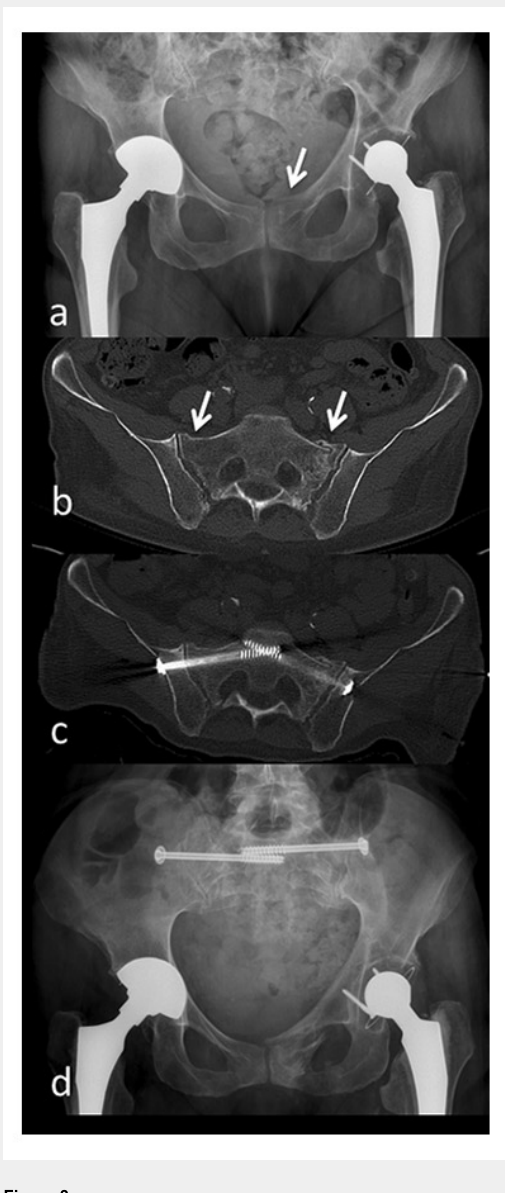
a) pubic ramus fracture on the left side b) CT scan six weeks after initial trauma due to increasing pain: There is a fracture of the massa lateralis on the left and a discontinuation of the cortical bone of the massa lateralis on the right c) CT-guided percutaneous screw fixation d) pelvic X-ray six weeks after surgery.